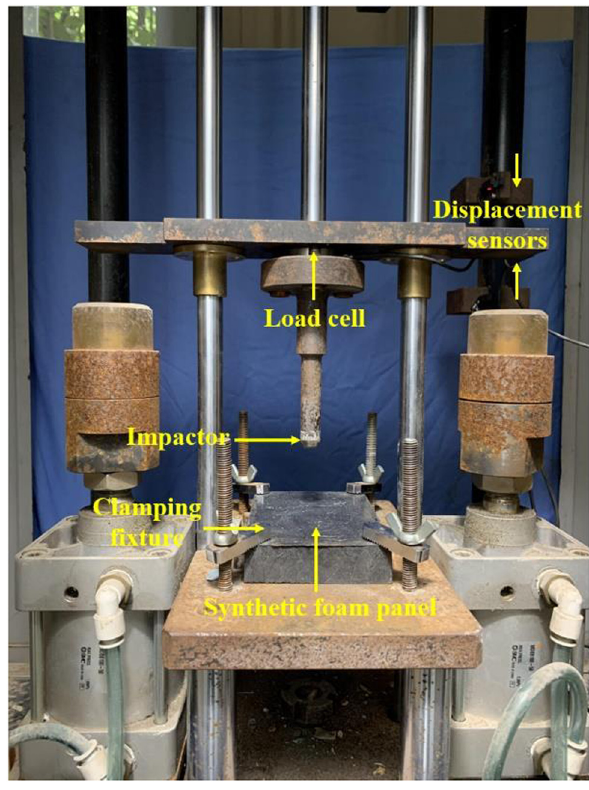
Figure 2: Test setup of drop - weight impact.